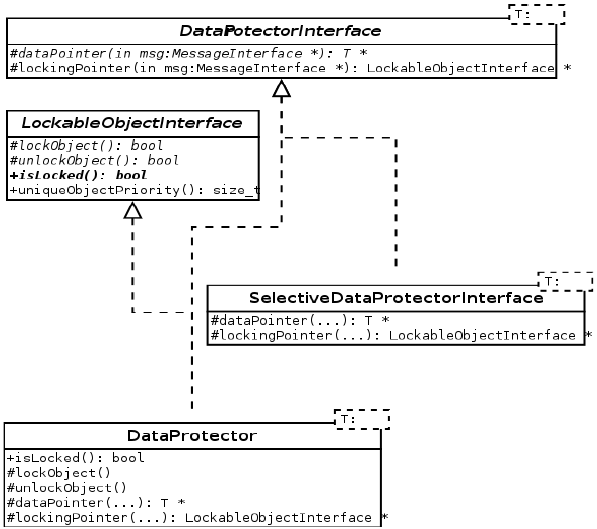
Figure 3. Class Diagram Related to Safe Data Access